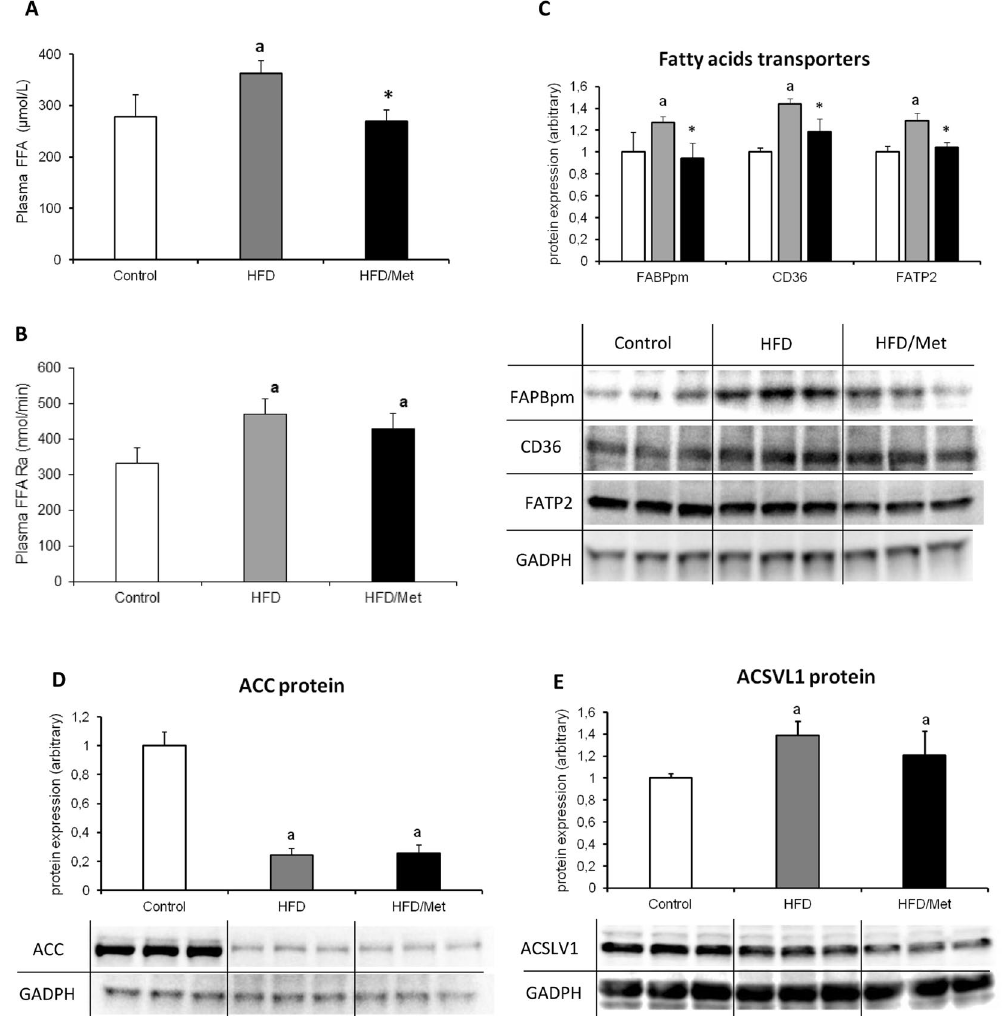
Figure 2. The impact of HFD consumption and metformin treatment on plasma fatty acids metabolism hepatic fatty acids transport proteins. Panel A and B present plasma fatty acid concentration and rate of appearance, respectively. Panel C presents hepatic content of plasma membrane fatty acid binding protein (FABPpm), fatty acid translocase (CD36) and fatty acid transport protein 2 (FATP2); Panel D and E present protein expression of acetyl-CoA carboxylase (ACC) and acyl-CoA synthetasease (ACSVL1) in rat liver. Values are mean + / − SD. Symbols denote statistical significance of p < 0.05 versus: a- vs. Control group; * - vs. HFD group, n = 8 per group; Significance by Anova with Tukey HSD post-hoc